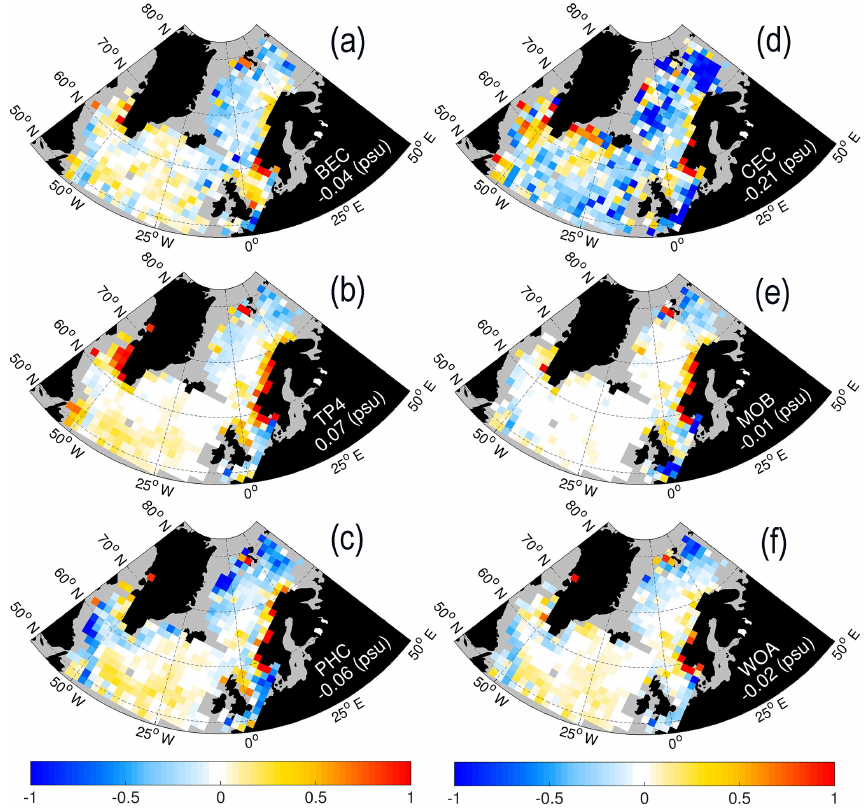
Figure 9. The mean deviation of SSS for the six datasets compared to in situ observations from CORA 5.1 during the 3 years of 2011–2013 in the northern North Atlantic and the Nordic Seas. The SSS observations are distributed across the coarse grid cells of 9 × 9 grids in TP4, with a gray mask if the valid observations are fewer than